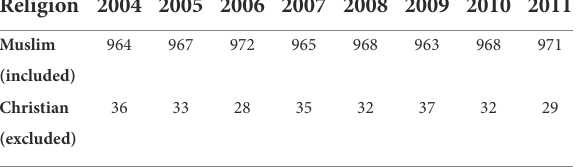
TABLE 2 Public support for terrorism in Jordan per